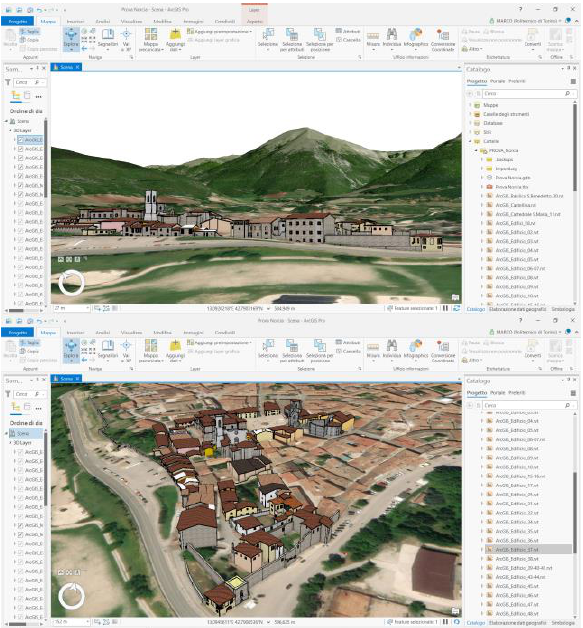
Figure 9. Visualisation of HBIM models in a 3D view of GIS